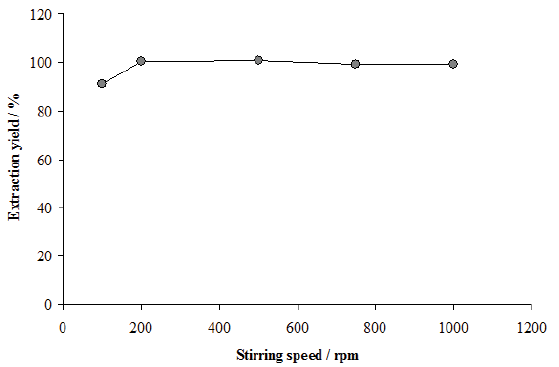
Figure 5. Effect of stirring speed on the extraction of Table 3. Ruggedness of the extraction protocol.